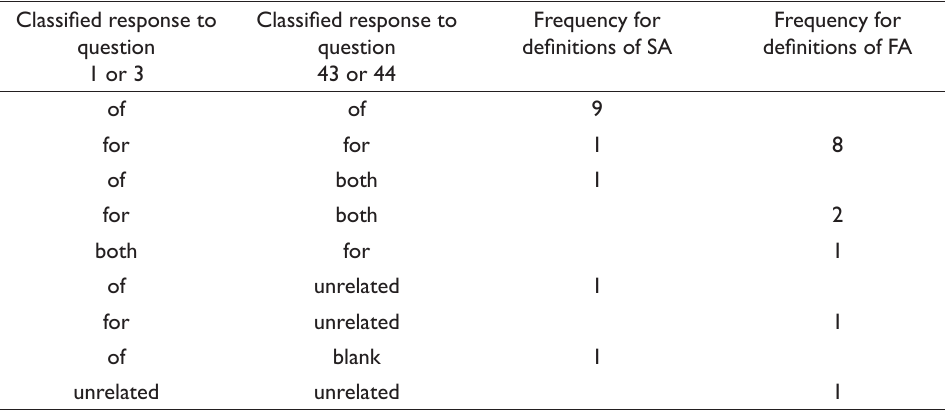
Table 1: The consistency of classified responses to the repeated questions asking for definitions of SA (questions 1 and 43) and FA (questions 3 and 44). Numbers refer to frequency of responses that were classified according to the scheme in columns 1 and 2 (‘for learning’ (for), ‘of learning’ (of), both, unrelated, and left blank). Only recorded permutations are given.